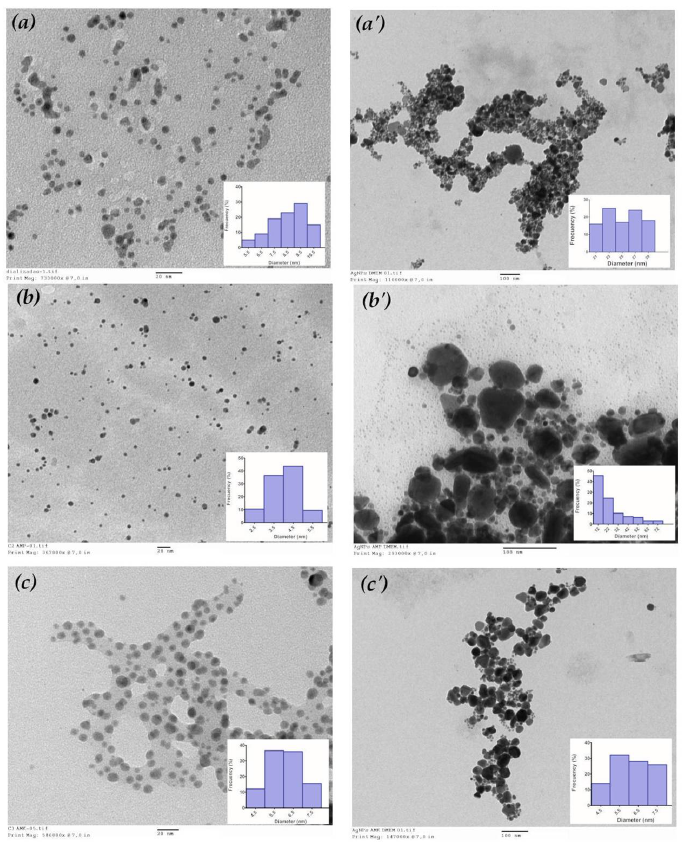
Figure 1. Morphological characterization of silver nanoparticles and their combinations with antibiotics. Transmission electron micrographs showing the formation of spherical and pseudospherical nanoparticles. ( a ) AgNPs; ( a’ ) AgNPs in DMEM; ( b ) AgNPs + AMP; ( b’ ) AgNPs + AMP in